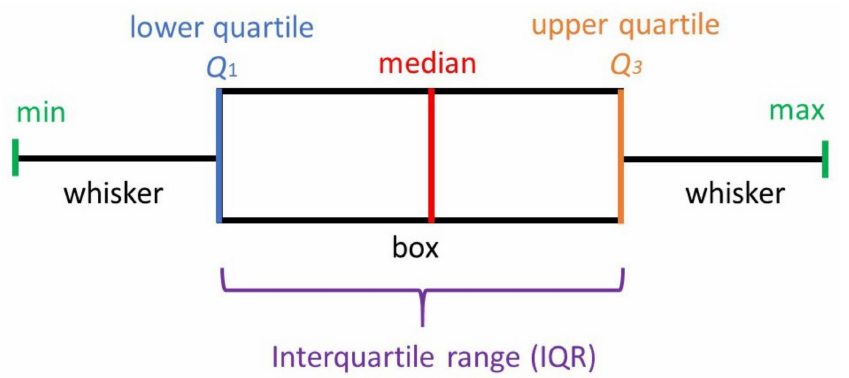
Figure 4. A taxonomy of a box plot. The figure shows six indicators: min, max, median, Q1, Q2, Q3, and the IQR in a reduced